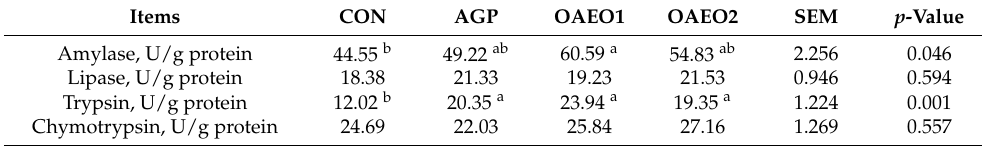
Table 4. Effect of OAEO on intestinal digestive enzyme activities of piglets.